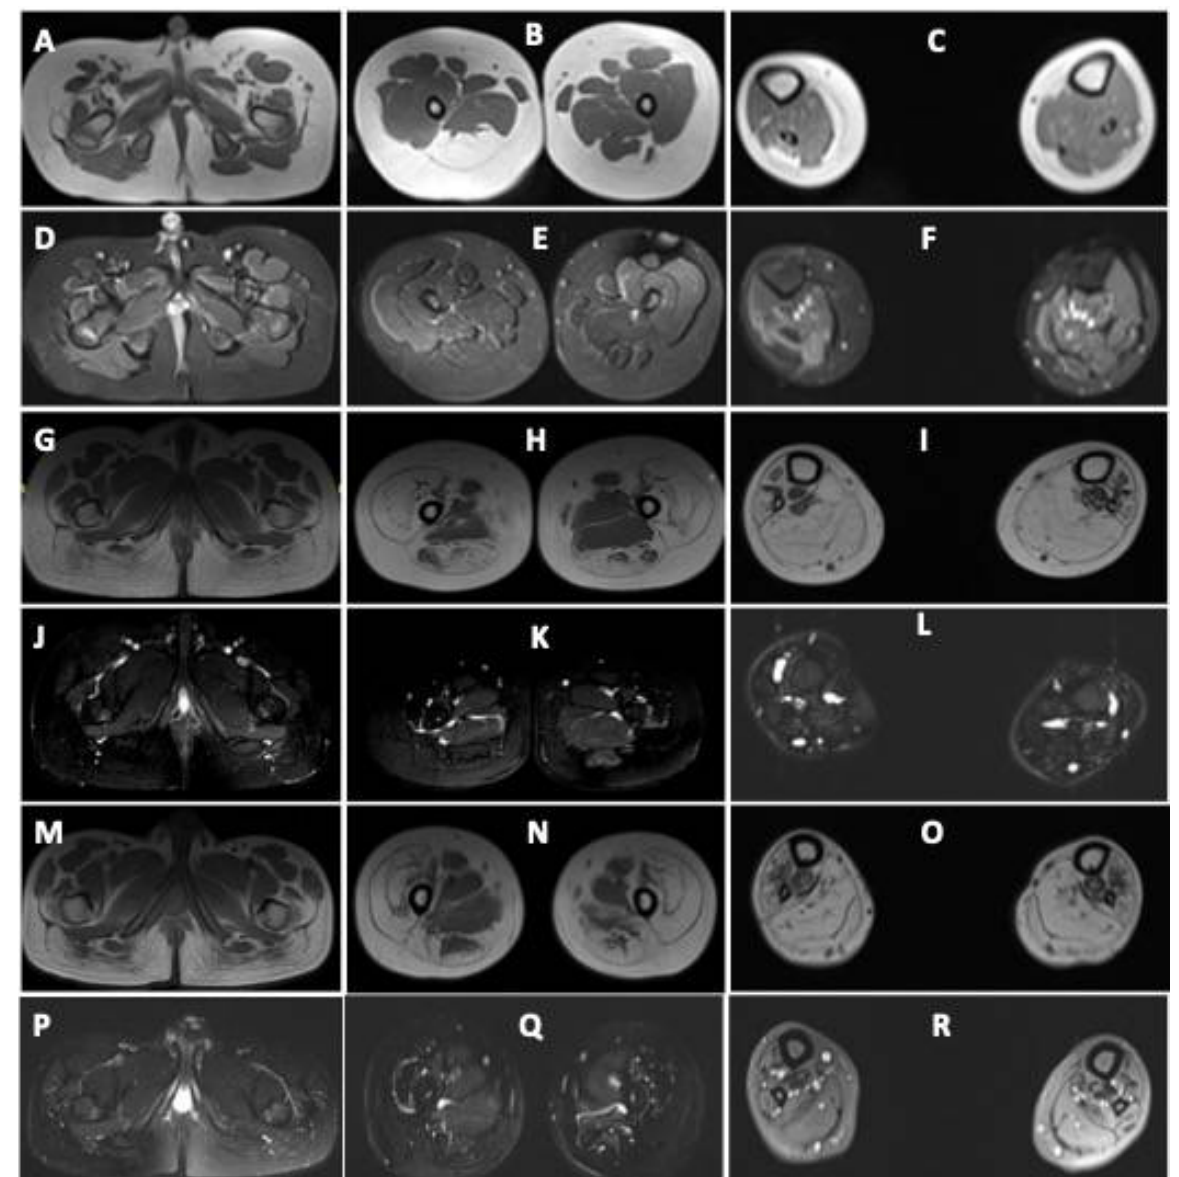
Figure 2. Muscle MRI images of patients with DA5D: ( A – F ) muscle MRI images of patient 1: axial T1-weighted sections at the level of the ( A ) pelvis, ( B ) midthigh, and ( C ) midleg reveal volume loss with fatty replacement, most pronounced in bilateral tensor fascia lata (Mercuri Grade 3), right semimembranosus (Grade 3), semitendinosus (Grade 3), bilateral biceps femoris (Grade 2b). Grade 2a fatty replacement is seen in the lateral compartment of the right leg and gastrocnemius. Axial fat-saturated T2-weighted sections at the level of the ( D ) pelvis, ( E ) midthigh, and ( F ) midleg reveal no edema; ( G – L ) MRI images of patient 2 and (M-R) of patient 3: axial T1-weighted sections at the level of the (G,M) pelvis, (H,N) midthigh, and ( I , O ) midleg reveal volume loss with fatty replacement, most pronounced in bilateral gluteus maximus (Mercuri Grade 3), vasti (Grade3), rectus femoris (Grade 2a), semimembranosus (Grade 2b), semitendinosus (Grade 2b), biceps femoris (Grade 2b). Grade 2b fatty replacement is seen in the anterior, lateral, and deep posterior compartments of the legs. The superficial posterior compartment of both legs reveals Grade 4 atrophy with fatty replacement. Axial fat-saturated T2- weighted sections at the level of the ( J , P ) pelvis, ( K , Q ) midthigh, and ( L , R ) midleg reveal no fluid signal. Family 2: patient 2 was a 17-year-old-boy evaluated during June 2018. He is the first